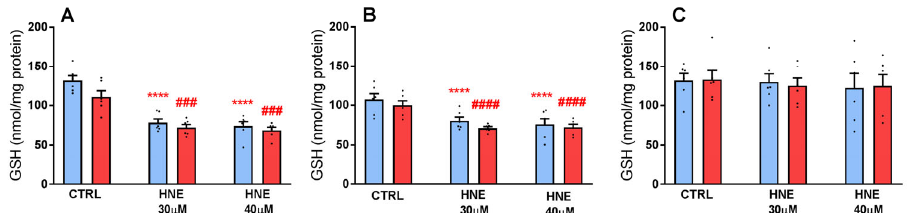
Figure 8. Effect of HNE incubation on intracellular glutathione content. GSH (blue bars) and total glutathione (red bars) levels were measured as described in Section 2.8, by HPCE analysis, in crude extracts obtained from HLE cells incubated for 30 min ( A ), 1 h ( B ), and 3 h ( C ), in the presence of the indicated HNE concentrations. Results are expressed as mean ± SEM of six independent exper ‐ iments. Significance was evaluated with respect to GSH value (*) or total glutathione value (#) of control cells incubated in the absence of the aldehyde (CTRL bars), using one ‐ way ANOVA fol ‐ lowed by Tukey post hoc test (###: p <0.001, ****, ####: p <0.0001).